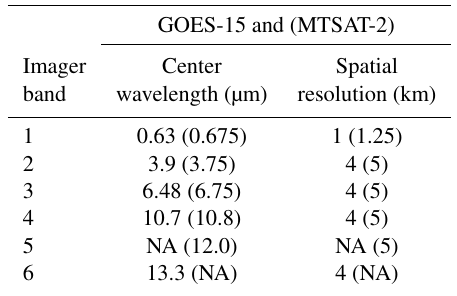
Table 2. Center wavelength and spatial resolution of spectral bands on board GOES-15 and MTSAT-2. MTSAT-2 is denoted in paren- theses. The GOES-15 imager carries bands 1–4 and 6 while the MTSAT-2 imager carries bands